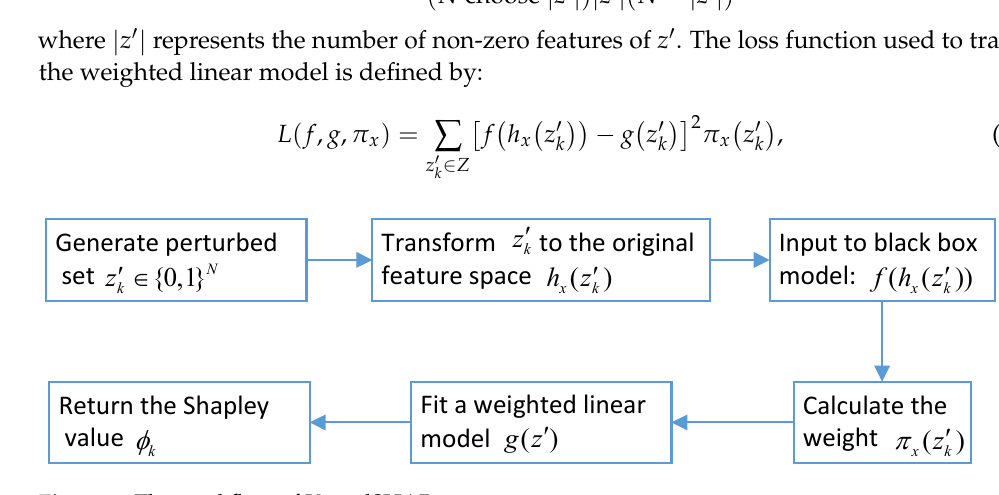
Figure 5. The workflow of